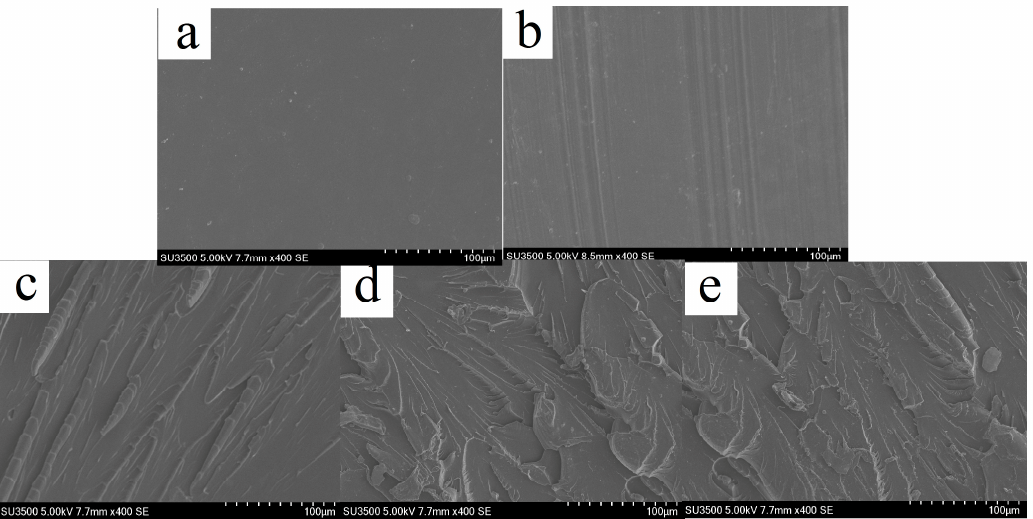
Figure 7. SEM images of fractures of DGEBA/IPDA thermoset with different contents of SITEUP. ( a – e ): 0%, 5%, 10%, 15%, 20%, respectively.